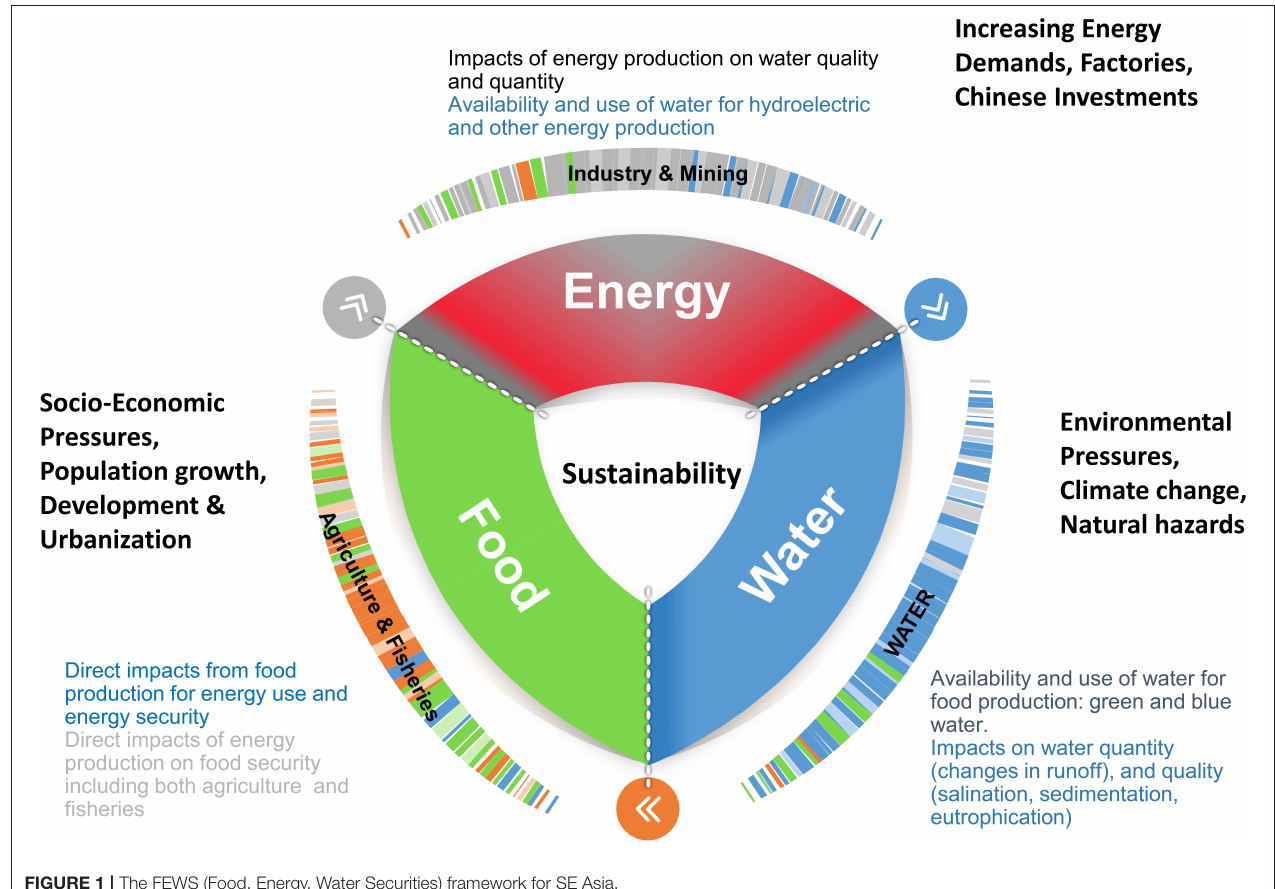
FIGURE 1 | The FEWS (Food, Energy, Water Securities) framework for SE Asia.